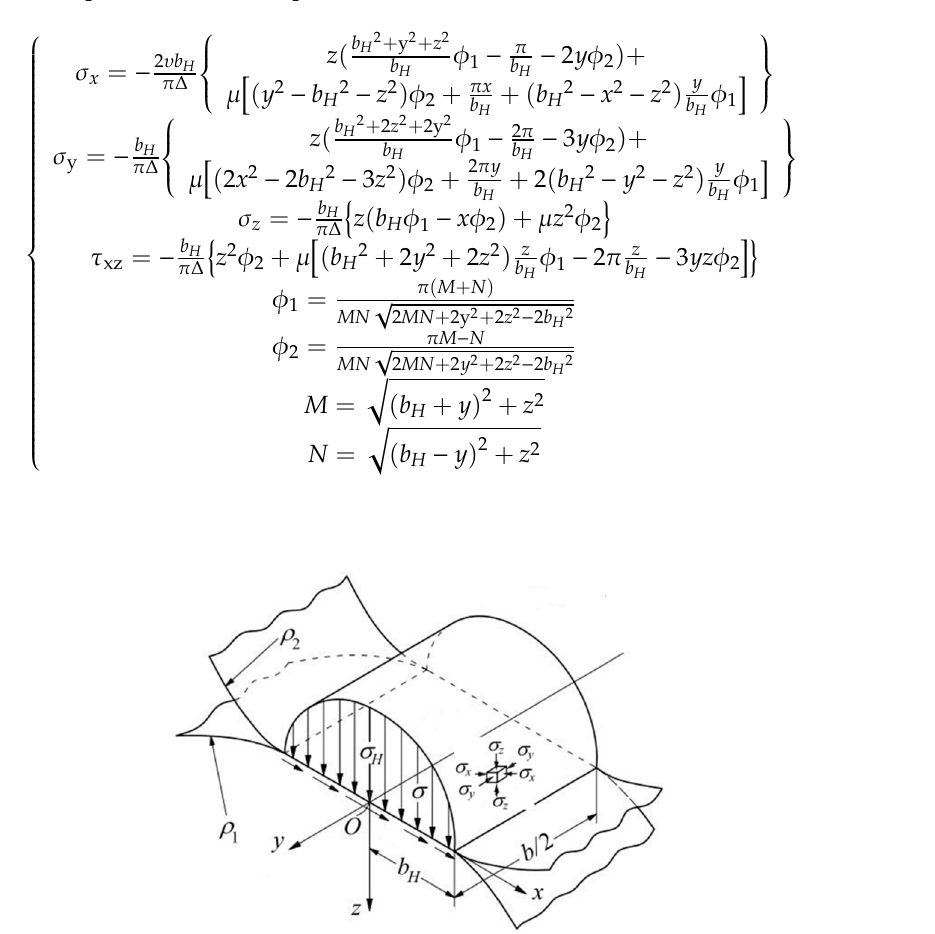
Figure 4. Schematic diagram of gear contact stress.